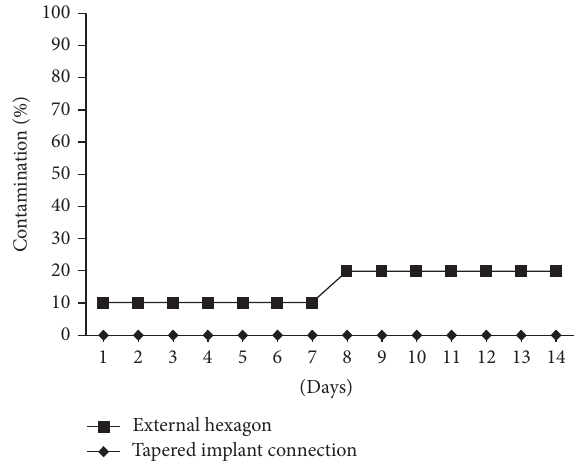
Figure 2: Contamination follow-up expressed as percentage over 14